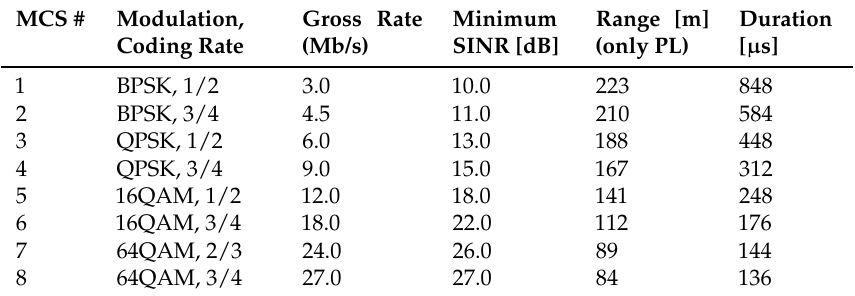
Table 2. IEEE 802.11p modulation and coding schemes and corresponding values.